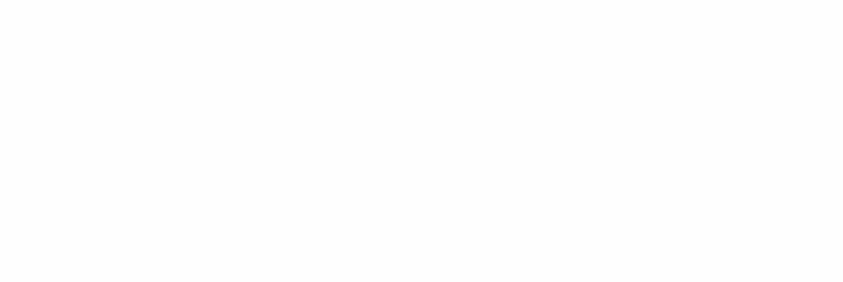
Fig. 4: Mean number of movement units (MUs) contained in unilateral (right or left arm) and bilateral reaches made when infants seated in unmodified (o) and modified (o)chair. Overall, there were significantly fewer MUs for reaches in the modified chair [F(1,207)= 11.30, p<.001]. More specifically, there were significantly less MUs during unilateral right and bilateral reaching movements compared to unilateral left arm reaches in this